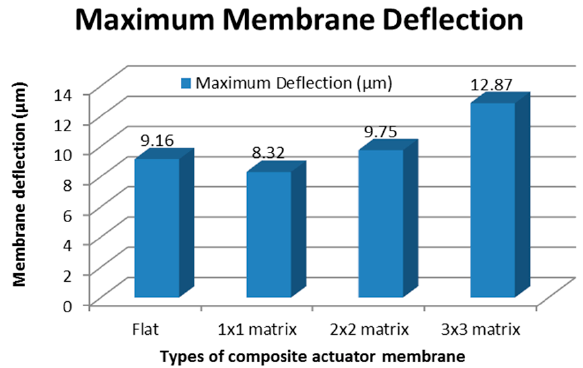
Figure 5. The deflection of the EM actuator membrane when an alternating current (AC) input voltage signal is applied.